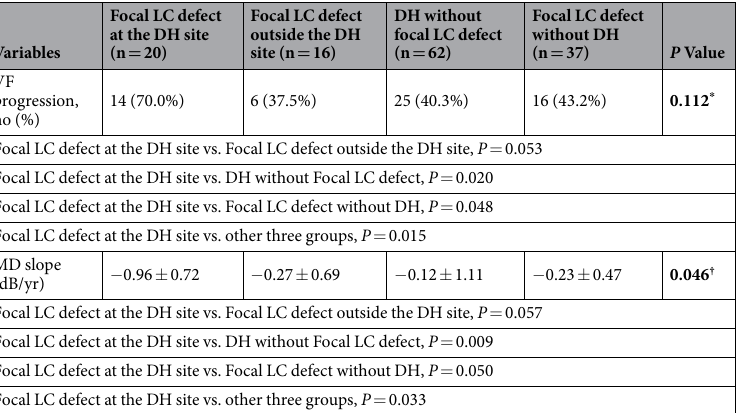
Focal LC defect at the DH site vs. Focal LC defect outside the DH site, P = 0.053 Focal LC defect at the DH site vs. DH without Focal LC defect, P = 0.020 Focal LC defect at the DH site vs. Focal LC defect without DH, P = 0.048 Focal LC defect at the DH site vs. other three groups, P = 0.015